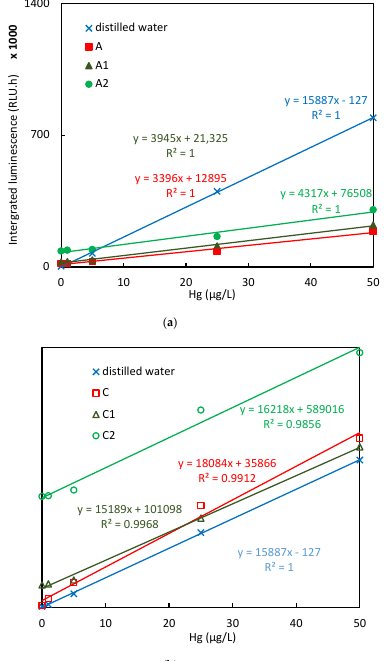
Figure 3 . Integrated values of the measured luminescence induced in E. coli ARL1 by soil samples and distilled water as a function of standard additions of mercury (II) chloride expressed as 0; 1; 5; 25; 50 μ g/L of mercury in final solution. ( a ) samples A, A1, A2 ; ( b ) samples C, C1, C2. Sensors 2020 , 20 , x